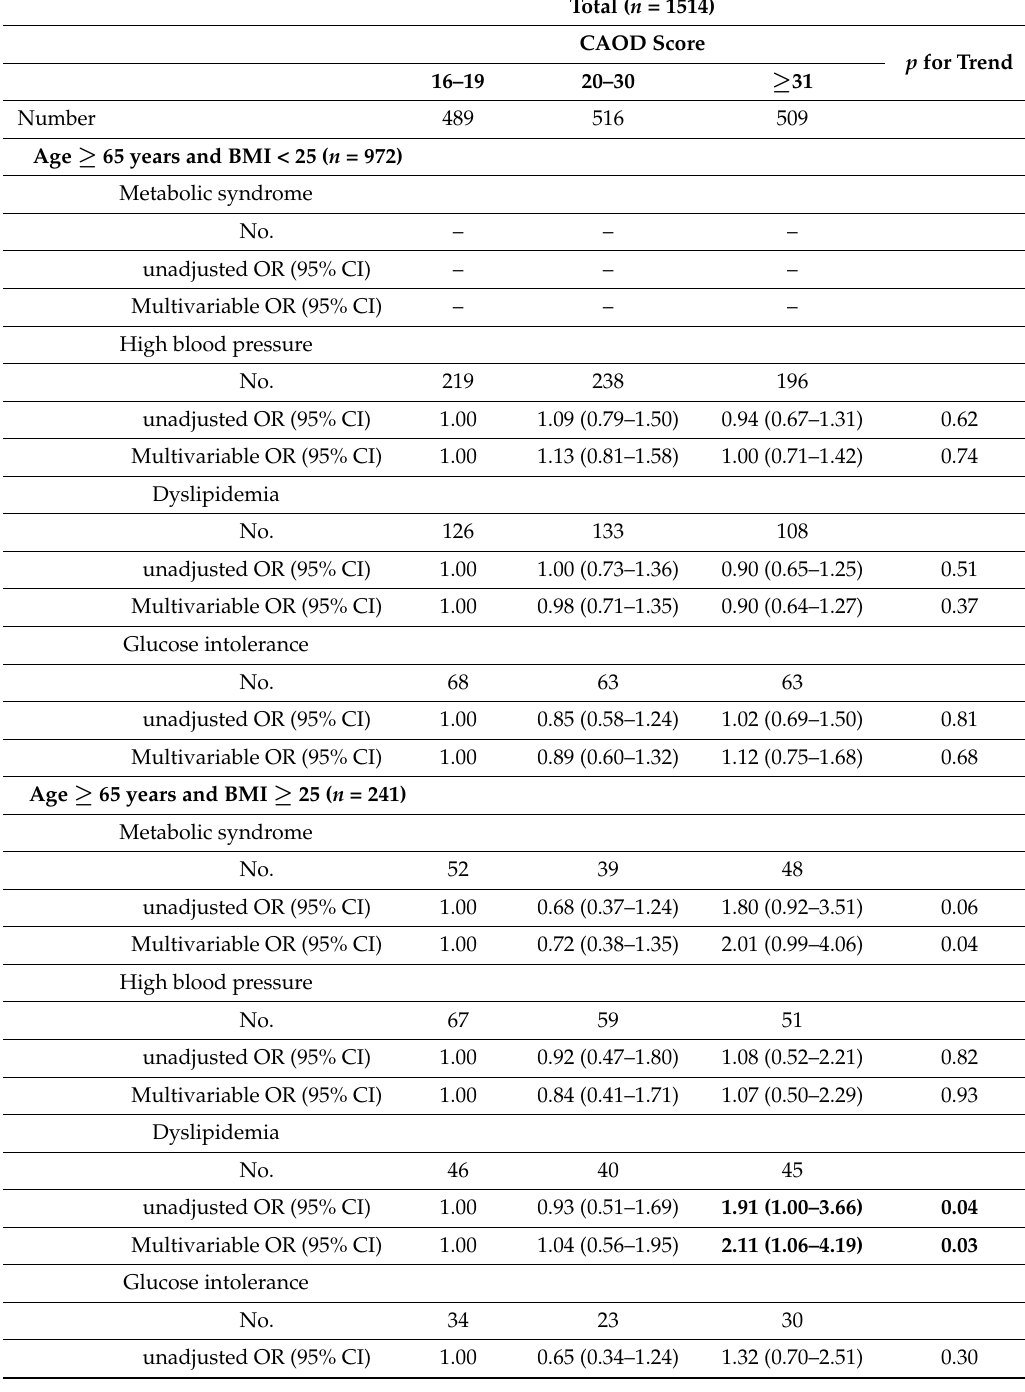
Table 3. Multivariable-adjusted odds ratios and 95% confidence intervals for metabolic syndrome and each of its component factors according to CAOD score categories stratified by a combination of overweight status and age